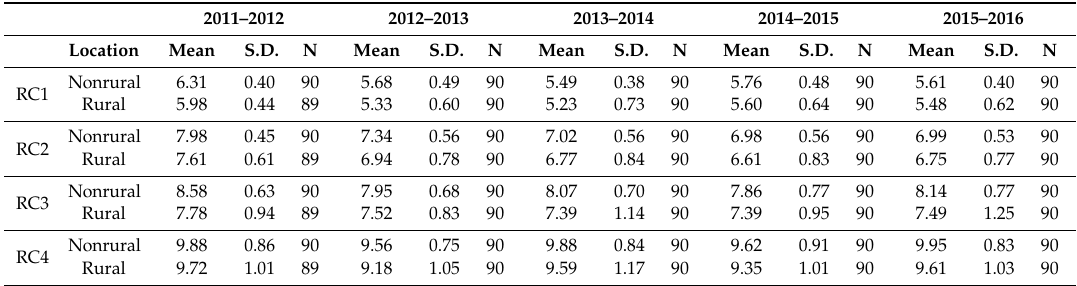
Table 1. Descriptive statistics of school districts’ fifth-grade State of Texas Assessment of Academic Readiness (STAAR) science performance by reporting categories (RCs) for school years from 2011 to